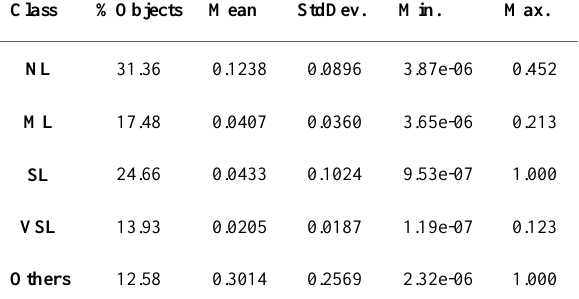
Table 1. Classification stability